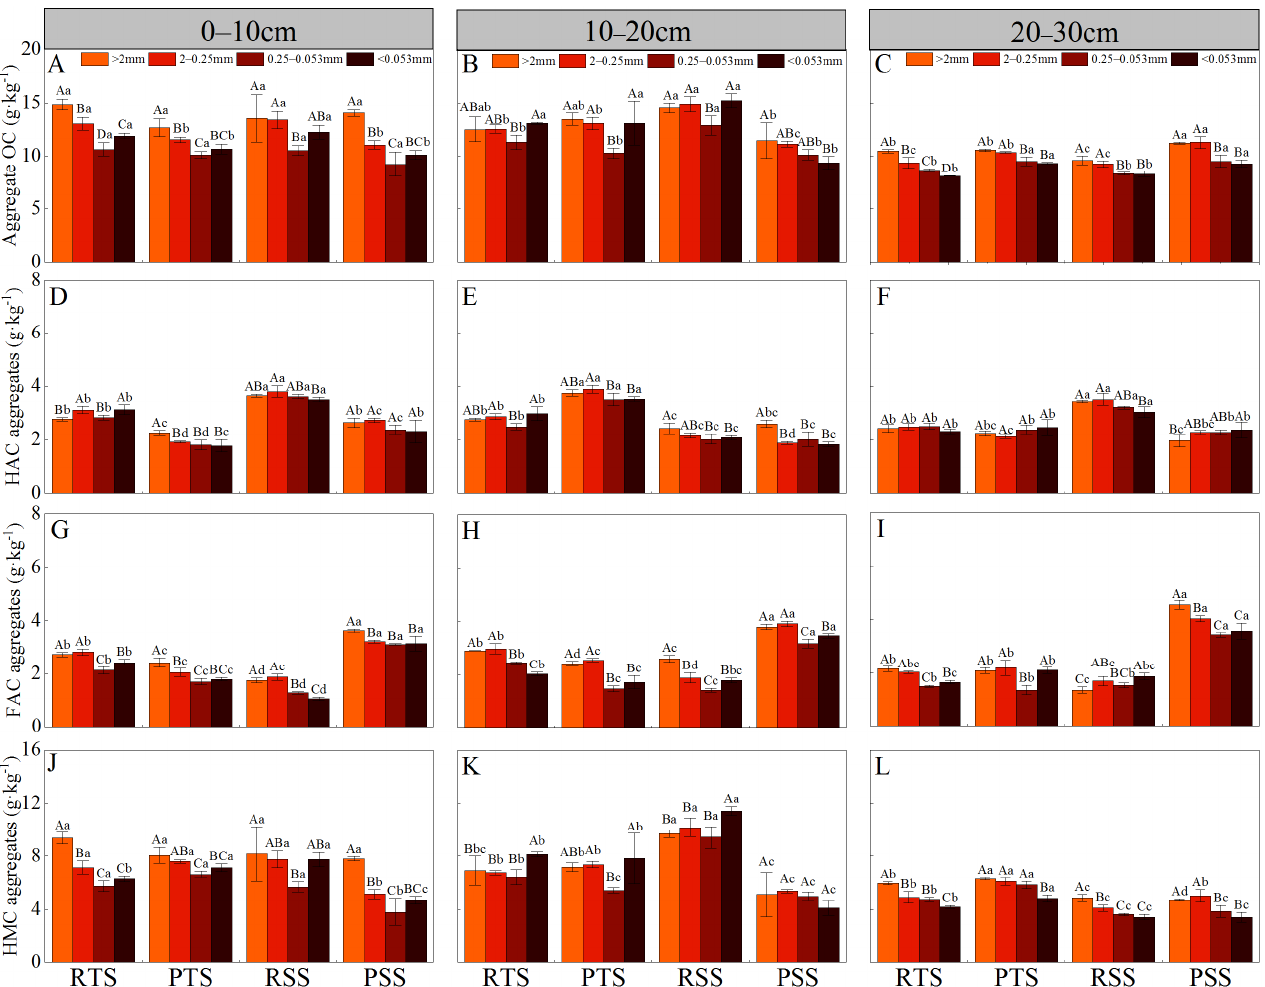
Figure 4. The organic carbon (OC) and humus carbon concentrations of the water-stable aggregate fractions under different tillage and straw return modes. ( A ) aggregate OC at 0–10 cm soil depths; ( B ) aggregate OC at 10–20 cm soil depths;( C ) aggregate OC at 20–30 cm soil depths; ( D ) HAC aggregate at 0–10 cm soil depths; ( E ) HAC aggregate at 10–20 cm soil depths; ( F ) HAC aggregate at 20–30 cm soil depths; ( G ) FAC aggregate at 0–10 cm soil depths; ( H ) FAC aggregate at 10–20 cm soil depths; ( I ) FAC aggregate at 20–30 cm soil depths; ( J ) HMC aggregate at 0–10 cm soil depths; ( K ) HMC aggregate at 10–20 cm soil depths; ( L ) HMC aggregate at 20–30 cm soil depths. RTS, rotary tillage with straw return; PTS, plow tillage with straw return; RSS, rotary tillage with straw strip return; PSS, plow tillage with straw strip return. Error bars represent the standard deviations of the mean ( n = 3). Different capital letters indicate significant differences ( p < 0.05) between organic and humus carbon associated with different aggregate sizes within the same treatment. Different lowercase letters indicate significant differences between treatments ( p < 0.05). T, tillage; S, straw management.